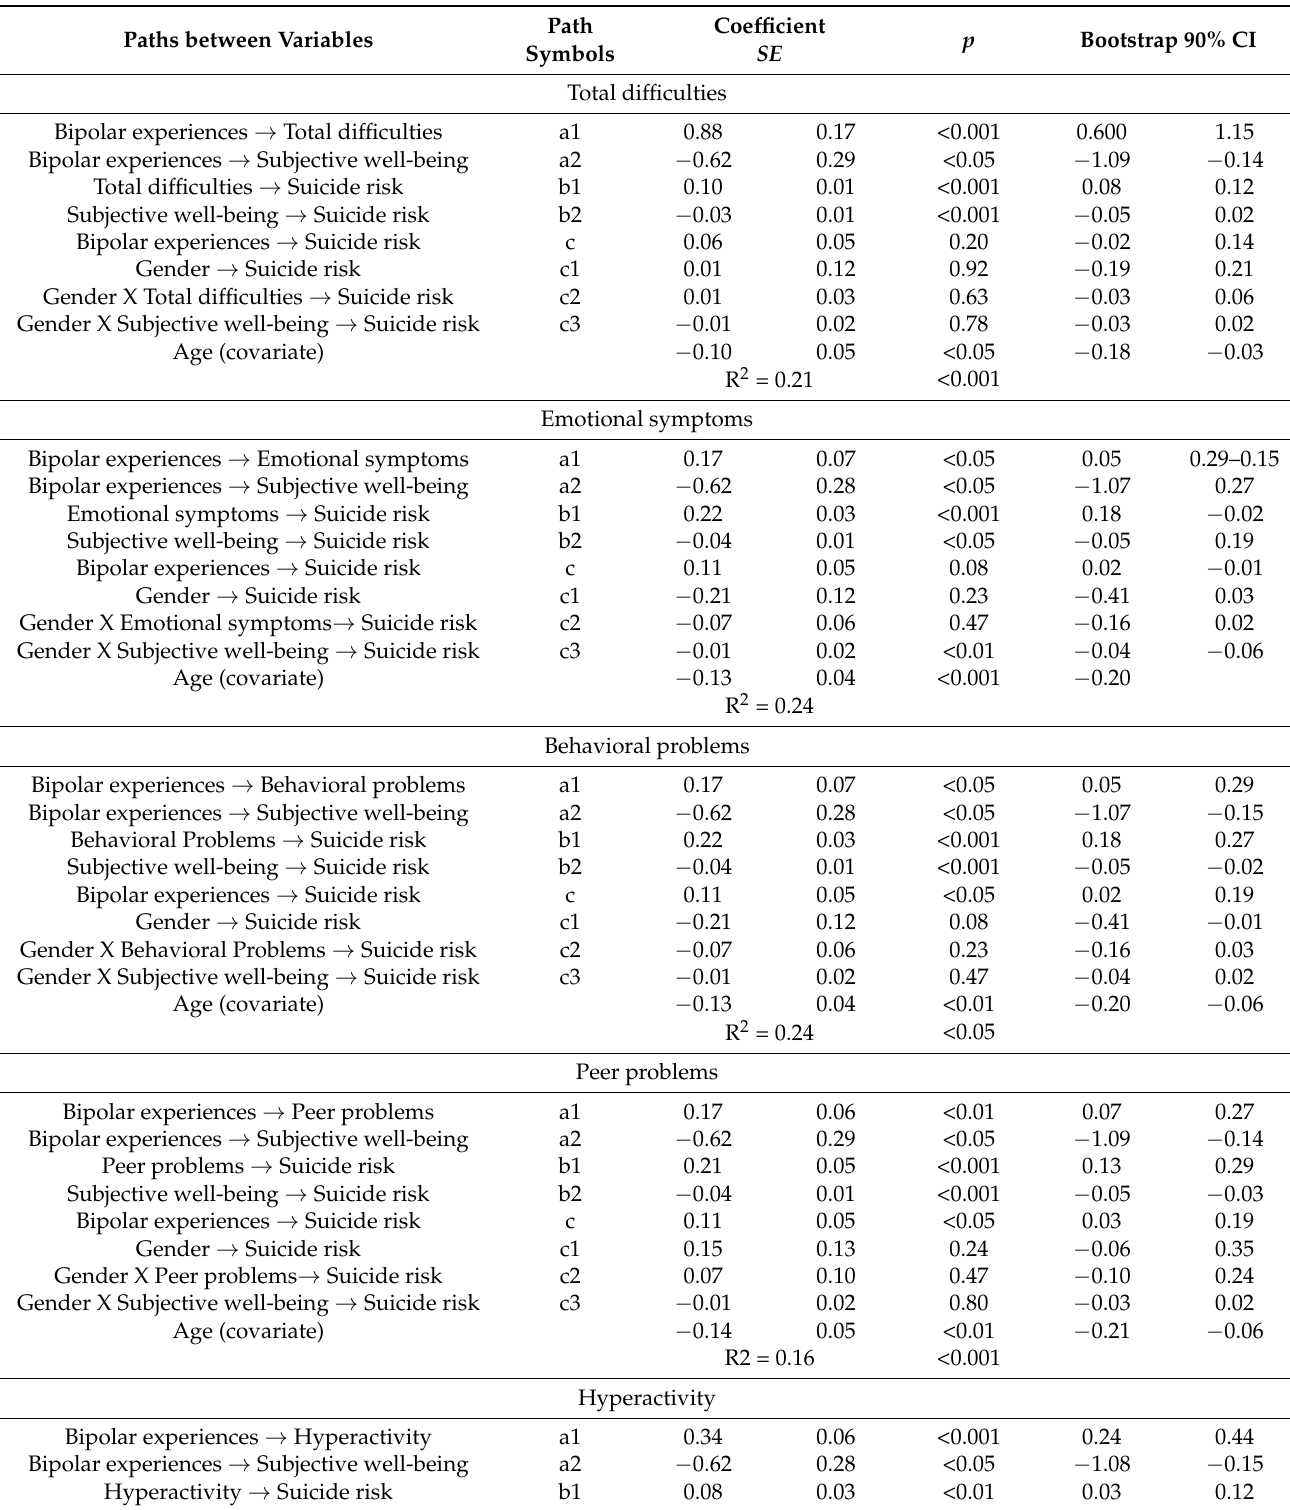
Table 3. Mediation model of total difficulties and subscales of difficulties and well-being on the relationship between bipolar experiences and suicide risk ( N = 467). Path Paths between Variables